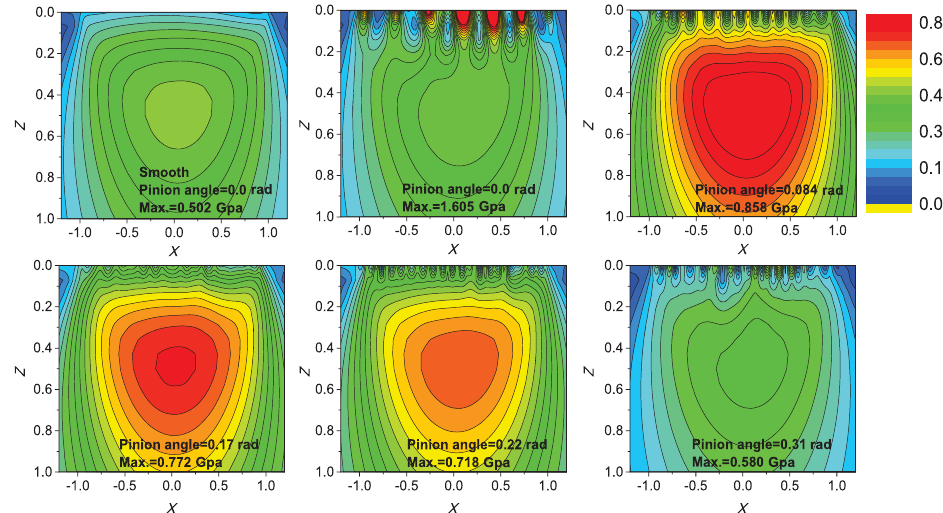
Fig. 12 Subsurface stress distributions at different meshing